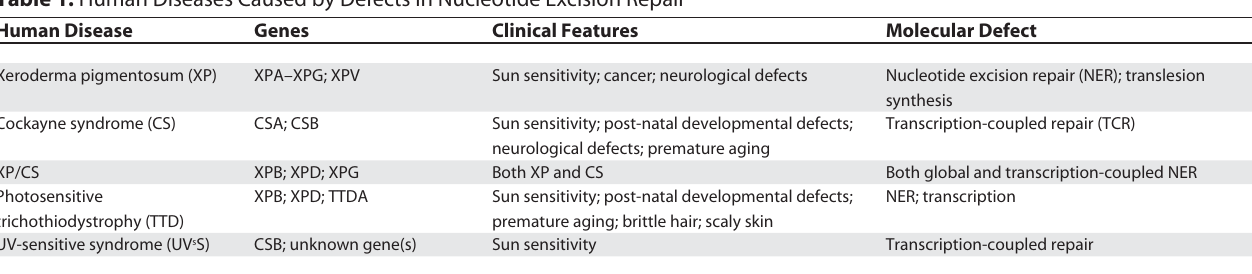
Table 1. Human Diseases Caused by Defects in Nucleotide Excision Repair Human